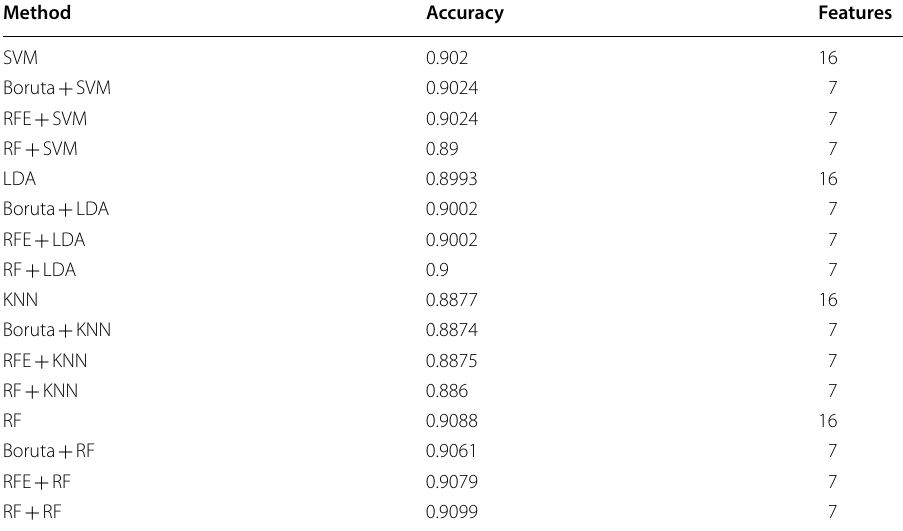
Table 8 Classification accuracy of different classifiers with bank marketing dataset